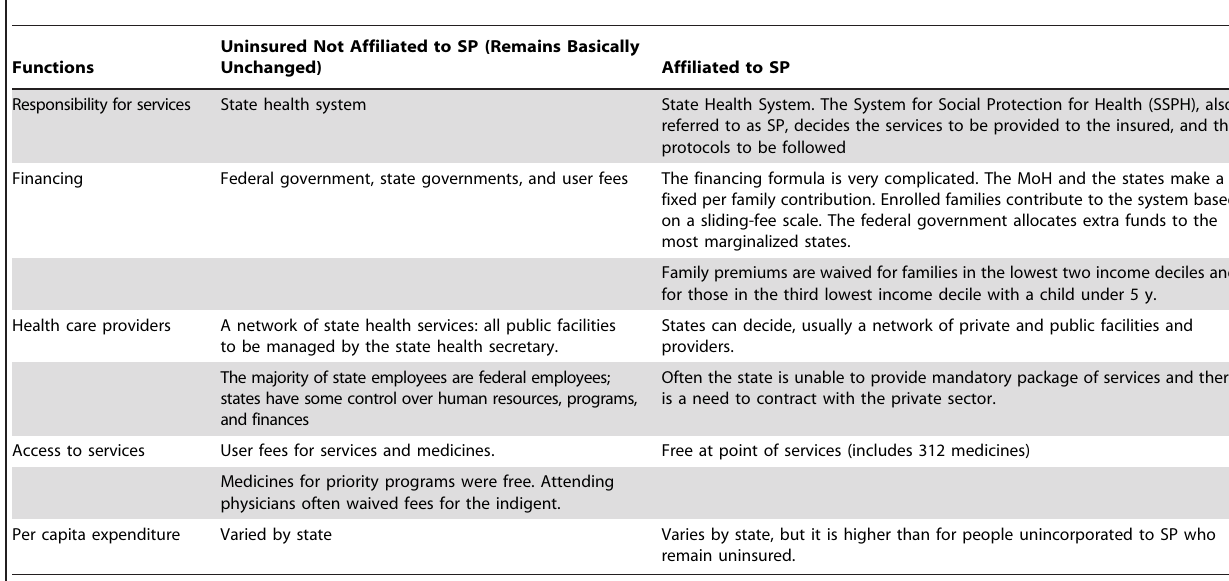
Table 5. Health care delivery for the uninsured after the creation of